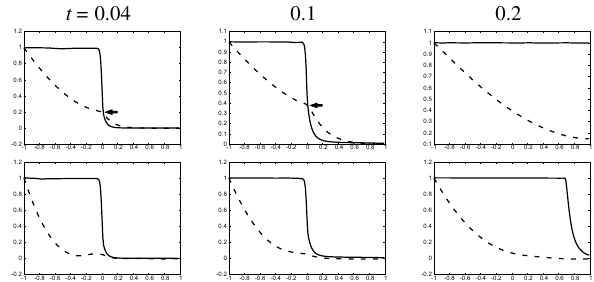
Fig. 21 Snapshots of numerical results without the HE effect ( γ ∗ ≡ γ ∗ 0 = 0.5 ). Crack growth at a given boundary displacement g = ± t ( 0,1 ) on Γ D . Blue color indicates low values, red color high e [ u ] values of the intensity of |